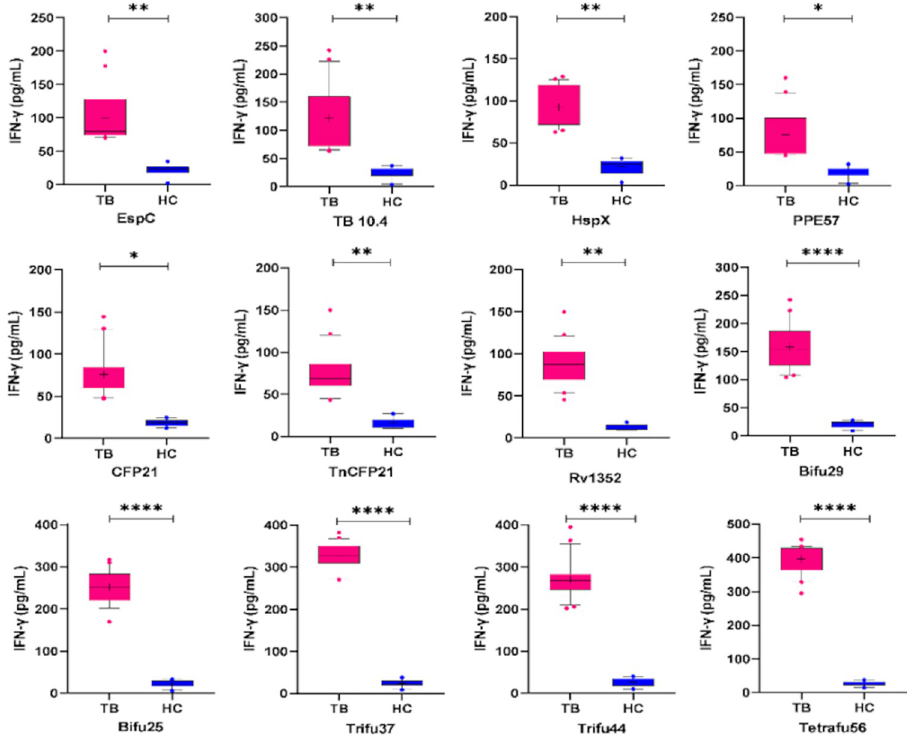
Fig 4. Box and whisker plots showing IFN- γ release against the single and their fusion antigens. � P > 0.01, �� P > 0.001, ��� P > 0.0001 and ���� P < 0.0001. The vertical line inside each box represents median values. IFN- γ released by PBMCs from the active TB group are several-fold higher as compared to those from the healthy group